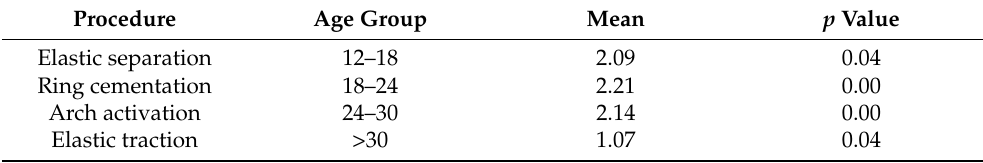
Table 1. Pain intensity during the orthodontic procedures depending on